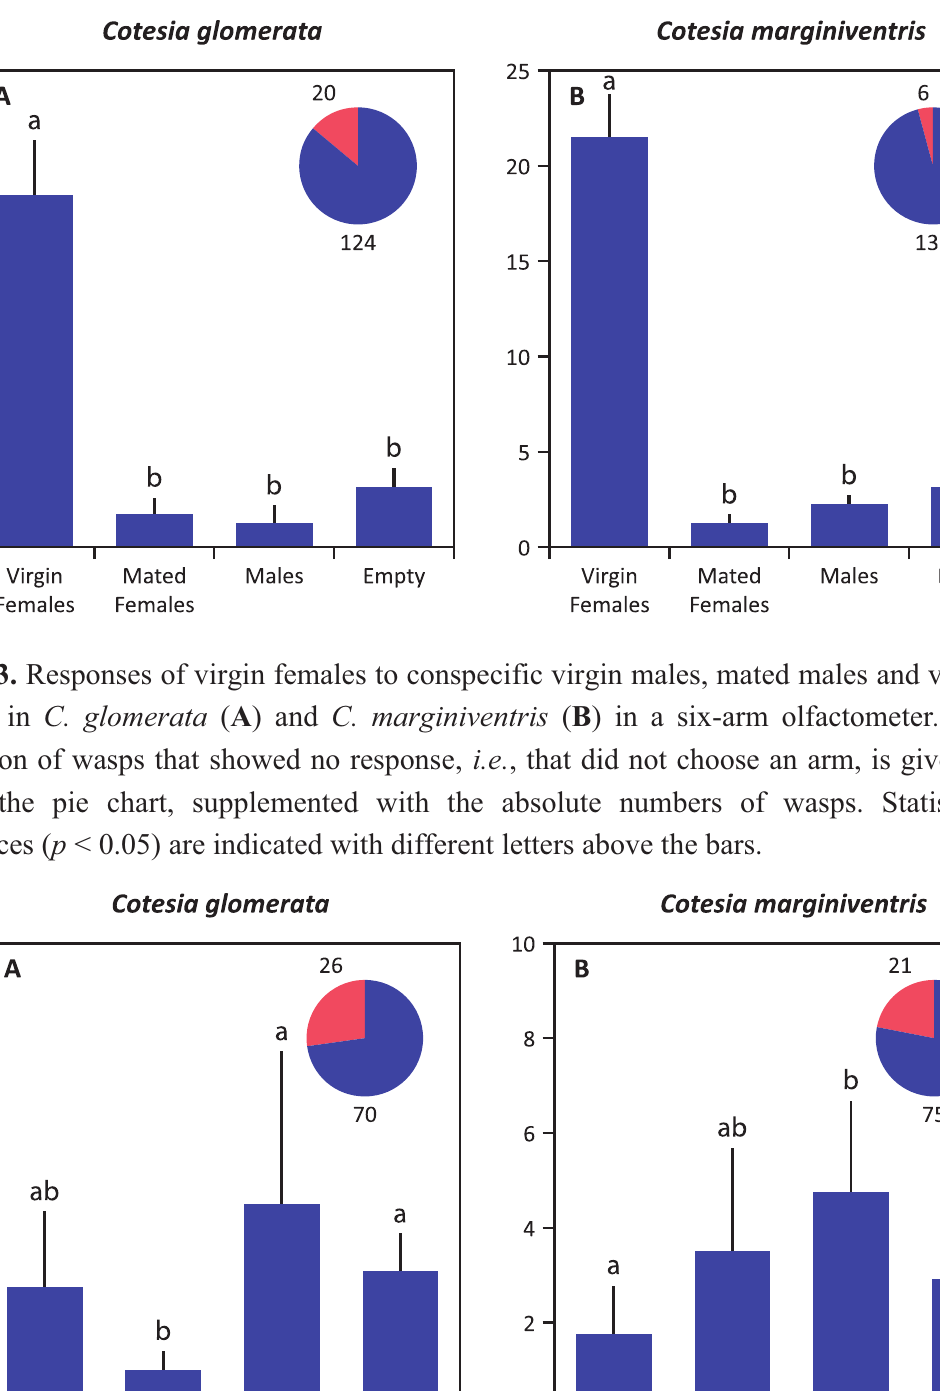
Figure 2. Responses of unmated males to conspecific virgin females, mated females and males in C. glomerata ( A ) and C. marginiventris ( B ) in a six-arm olfactometer . The proportion of wasps that showed no response, i.e. , that did not choose an arm, is given in red in the pie chart, supplemented with the absolute numbers of wasps. Statistical differences ( p < 0.05) are indicated with different letters above the bars.